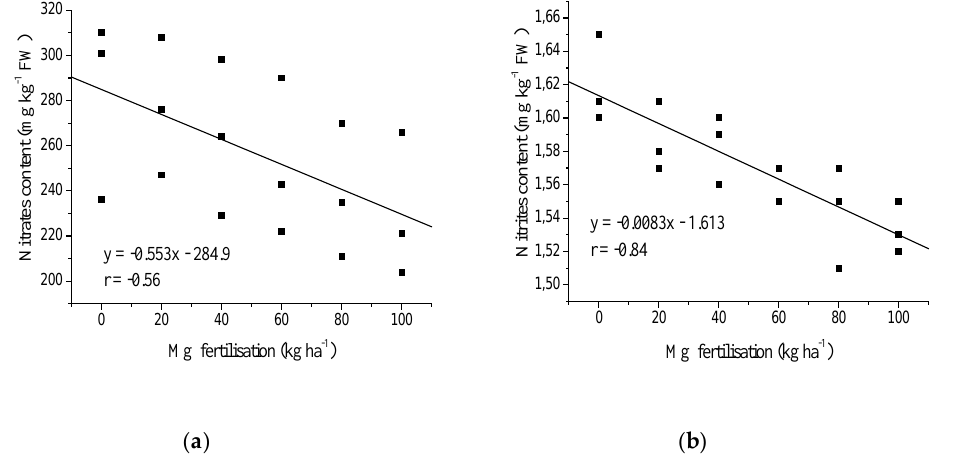
Figure 7. The significant relationship between the dose of magnesium fertilisation and NO 3 ˉ (a), NO 2 ˉ (b) contents in the potato tubers after 6 months of storage. R – p ≤ 0.05.